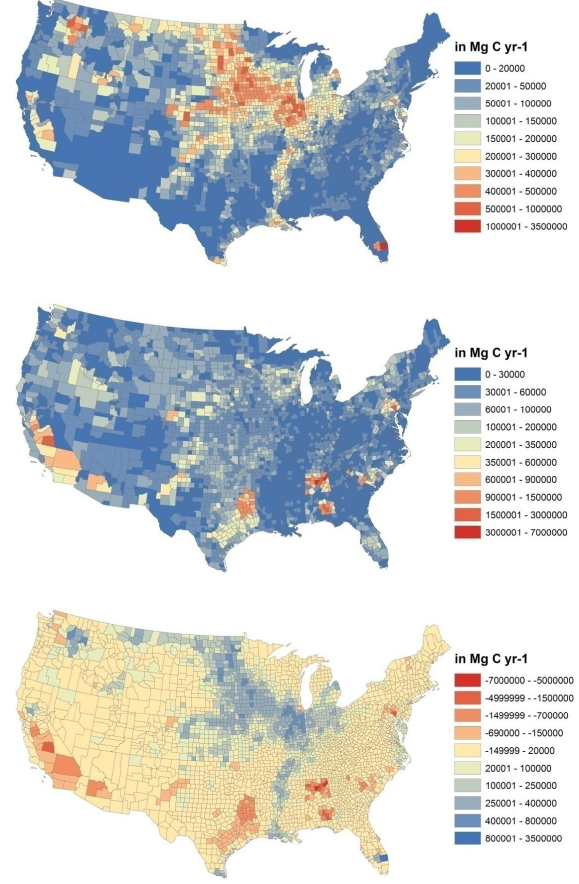
Figure 2. Spatial distributions of annual crop production (top); crop consumption (middle); and crop NEP (bottom) for 2003. Data from CDIAC